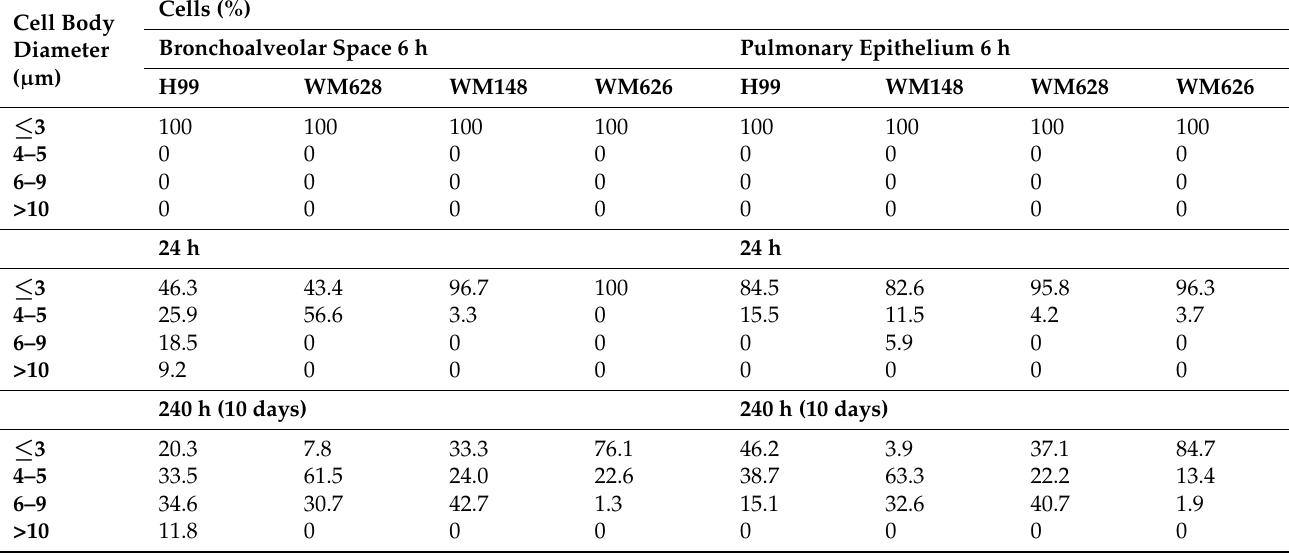
Table 2. Cell body diameter variation in C. neoformans in